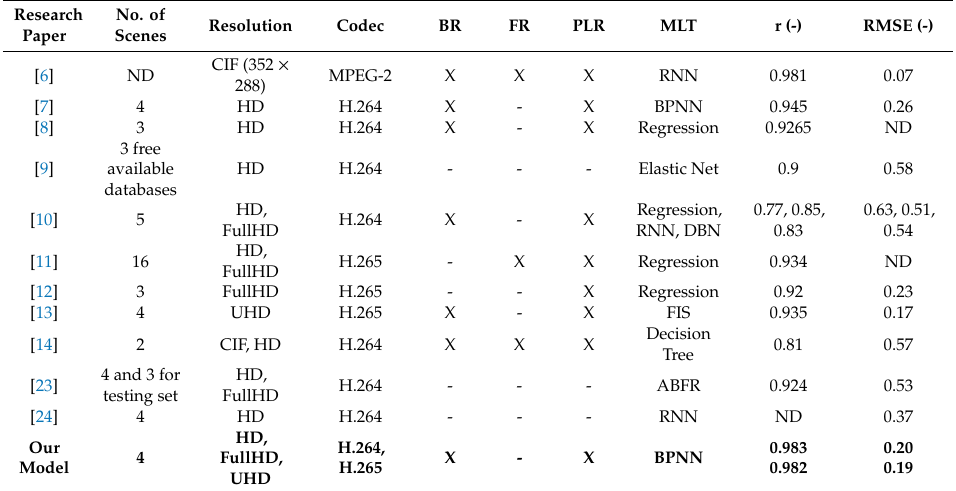
Table 3. Comparison of the proposed model with published models for subjective prediction of video